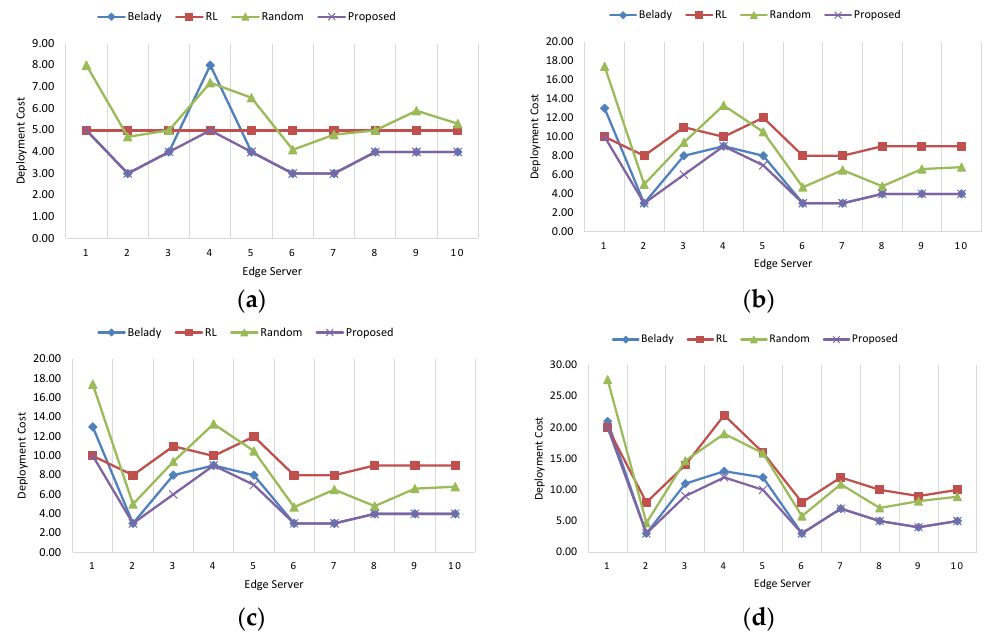
Figure 3. The results of deployment costs for the homogeneous configuration. ( a ) Number of request: 5; ( b ) Number of request: 10; ( c ) Number of request: 15; ( d ) Number of request: 20.